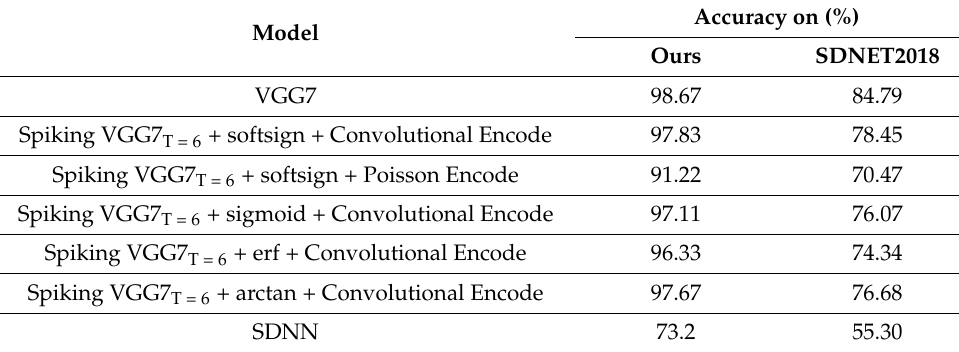
Table 2. The testing accuracy for different training methods for two datasets.